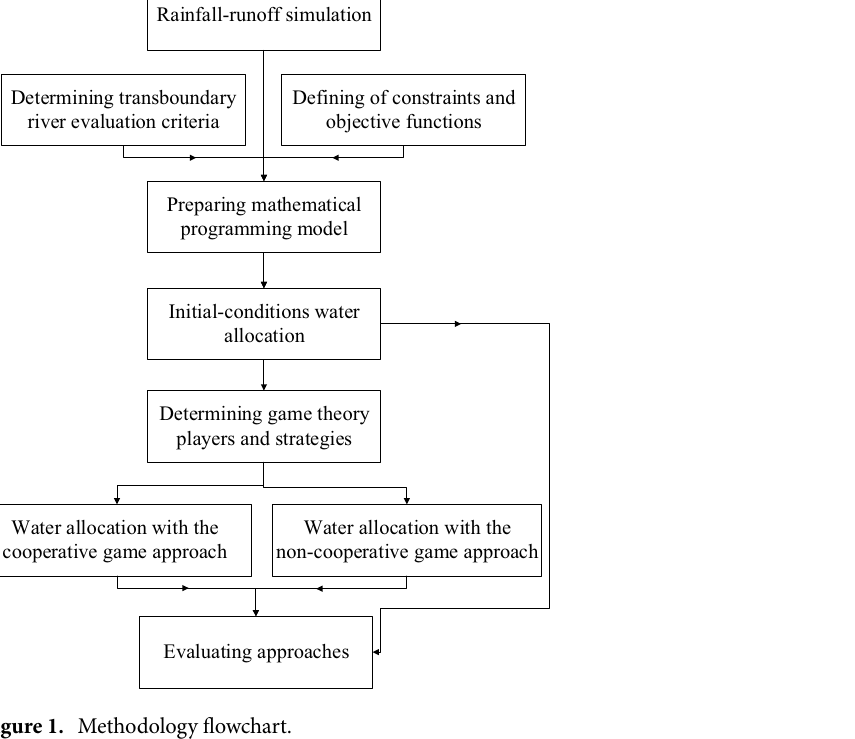
Figure 1. Methodology